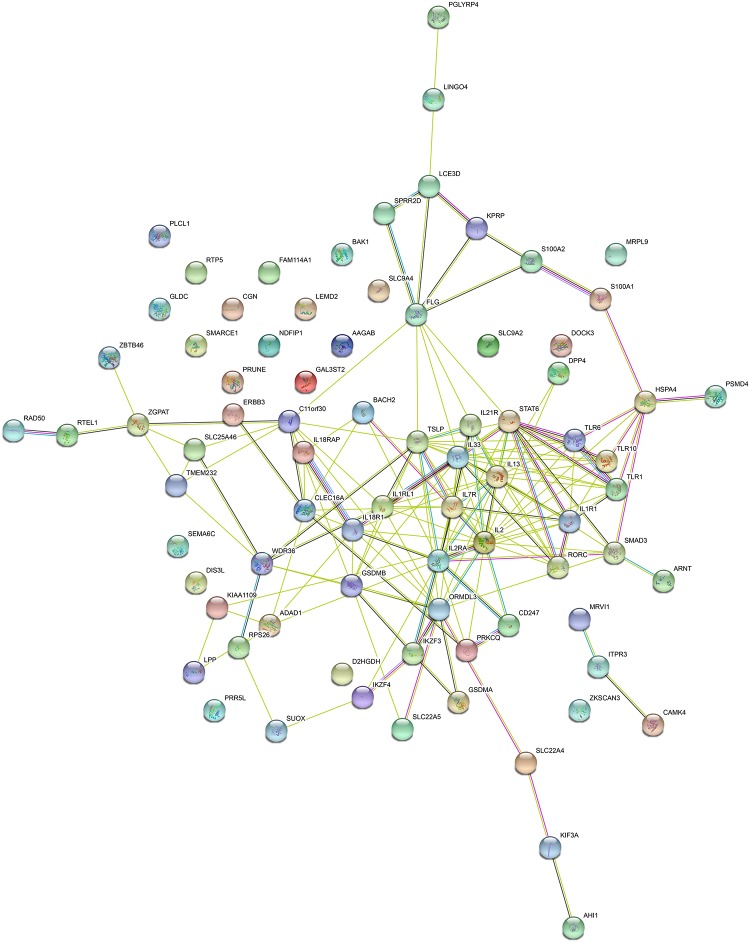
PPI network for shared risk genes (excluding those in MHC region).